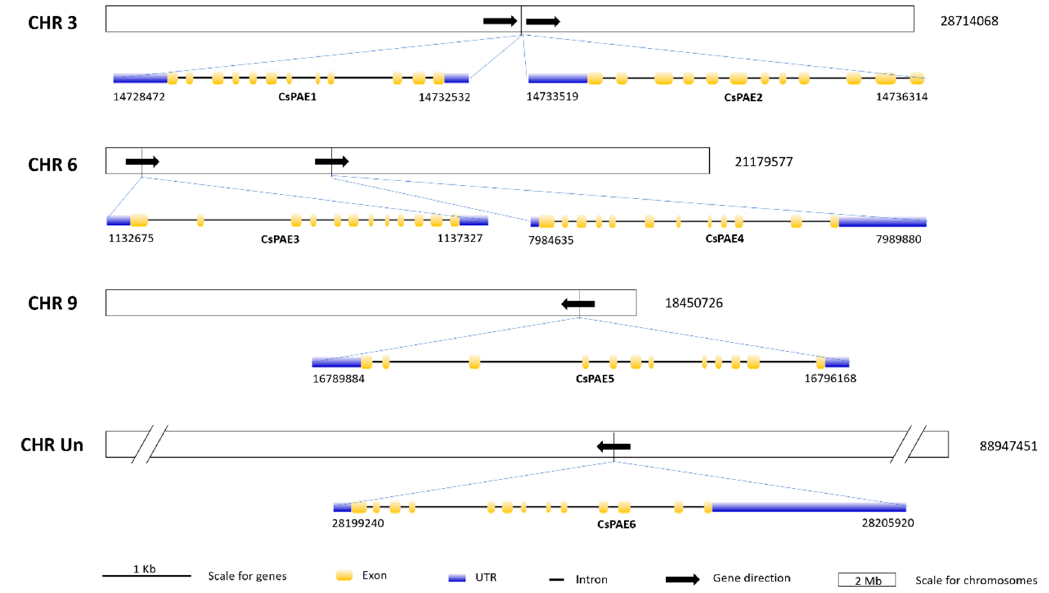
Figure 3. Chromosomal localizations and intron–exon structures of CsPAE genes. The localizations of CsPAEs were visualized by Mapchart V2.2, and the intron–exon structures of CsPAEs were determined using GSDS V2.0. Blue rectangles represent untranslated regions (UTRs) at 5 prime and 3 prime ends; yellow rectangles represent exons and blank lines represent introns; black arrows represent gene direction. The sizes of exons, introns, and UTRs are up to scale for a gene, while the sizes of chromosomes are scaled for chromosomes. The sizes of chromosomes are written on the right of them, and the gene localizations (the start and the end positions) are written below the genes.